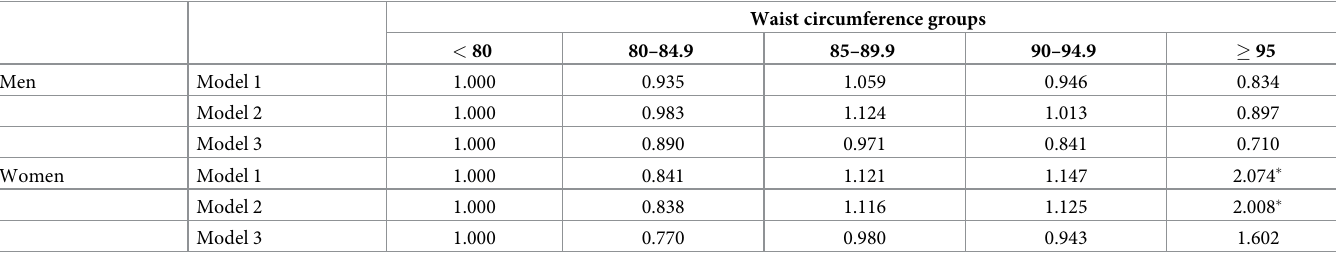
Table 3. Hazard ratio for cardiovascular disease mortality according to waist circumference